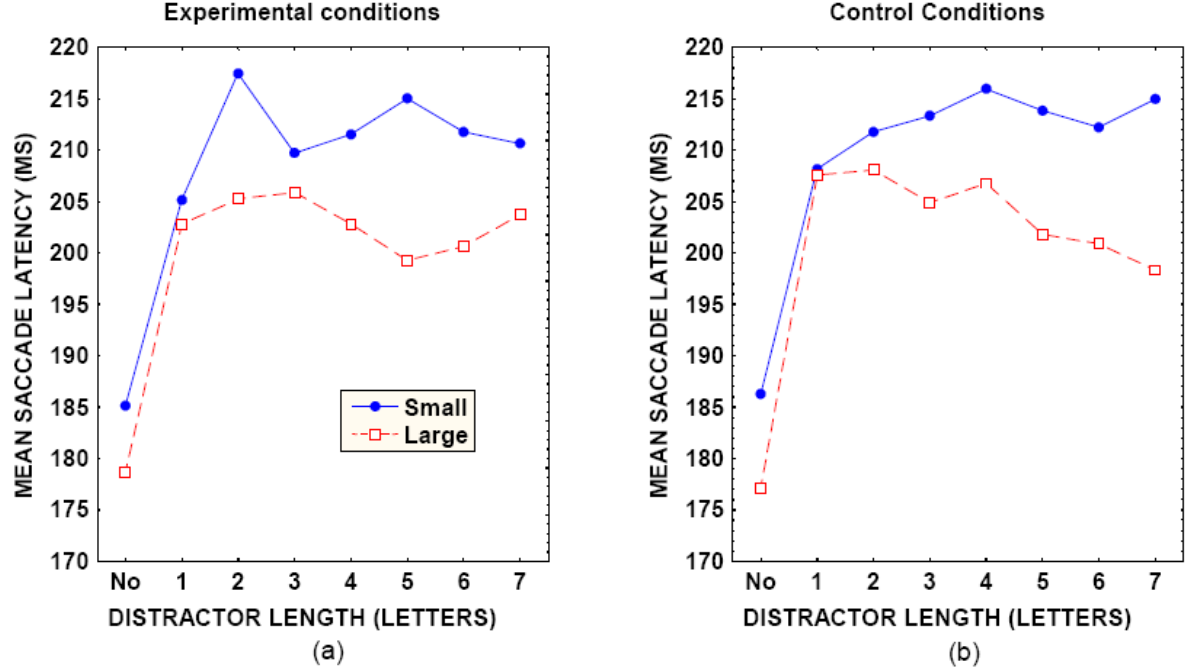
Figure 4. Mean latency (in ms) of the initial saccade made towards the isolated target letter in the character-size experiment, as a function of the length of the distractor string (in number of letters) and the angular size of the characters (small vs. large) in both the experimental (a) and the control (b)